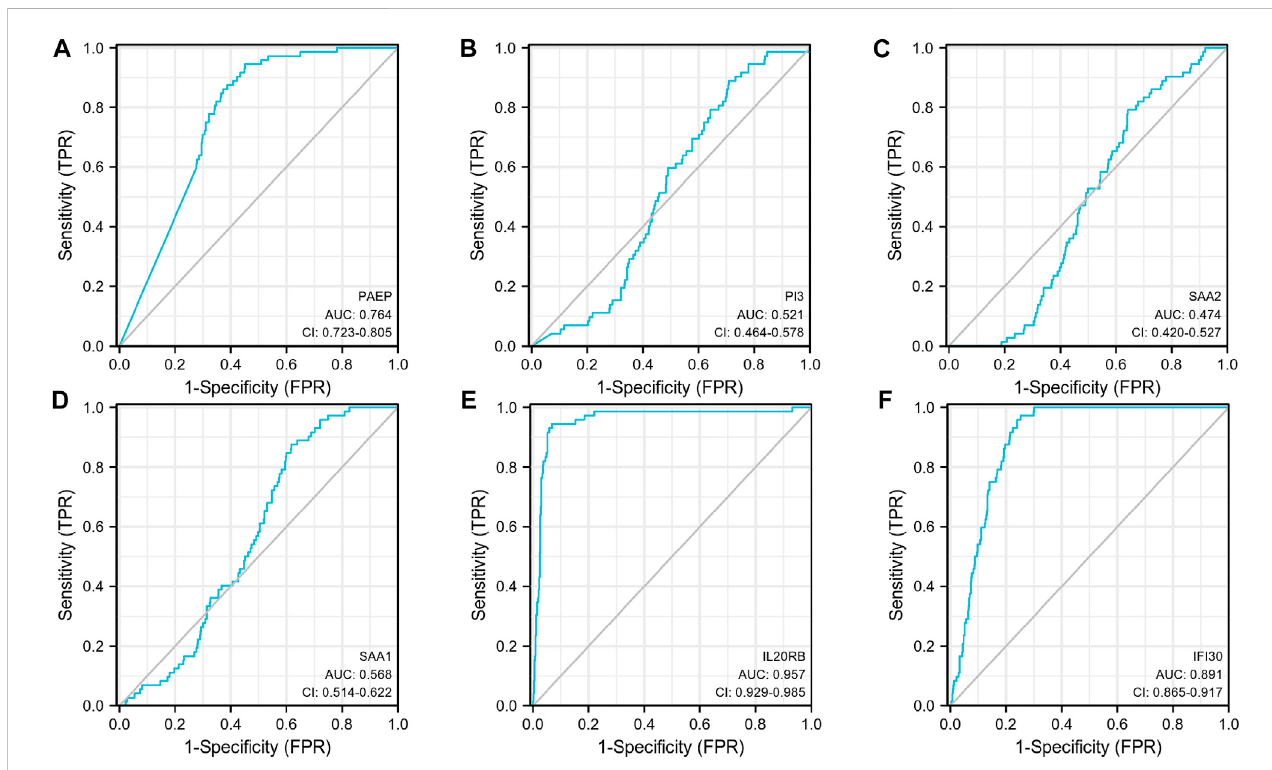
FIGURE 6 Single-indicator ROC curvesfor PAEP, PI3, SAA2, SAA1, IL20RB, and IFI30 for diagnosis of KIRC. (A) PAEP, (B) PI3, (C) SAA2, (D) SAA1, (E) IL20RB, (F)